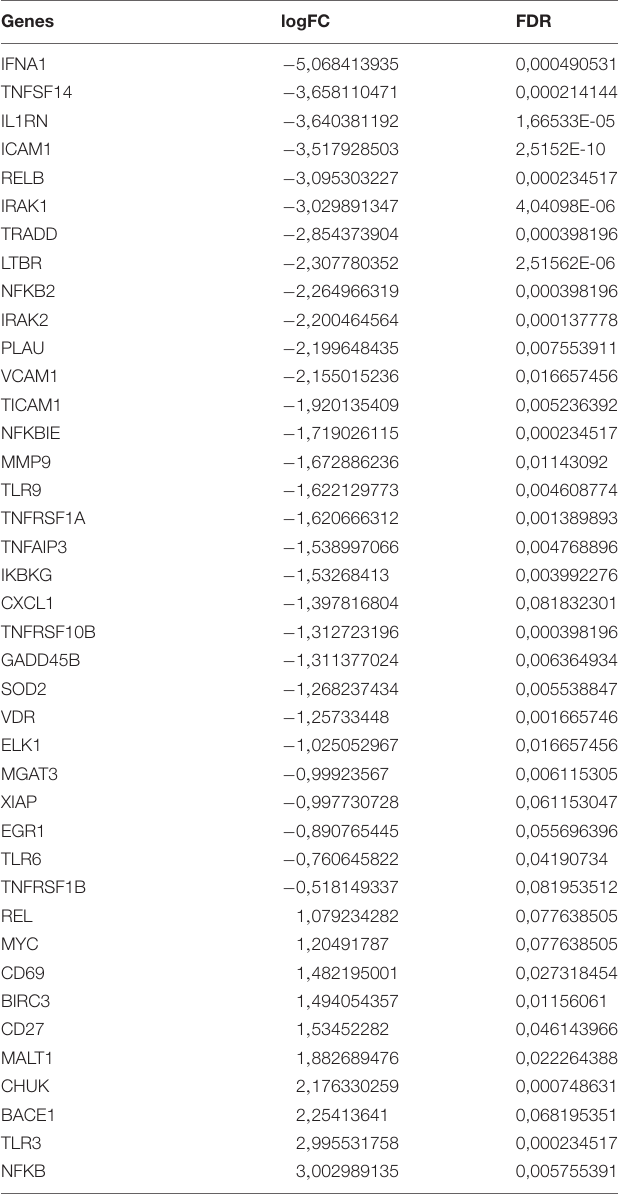
TABLE 2 | Statistically significant differentially expressed mRNAs in PBMCs from AD patients, compared to controls. Genes logFC